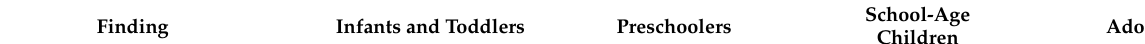
Table 2. Overview of findings of early CF lung disease according to age group discussed in this